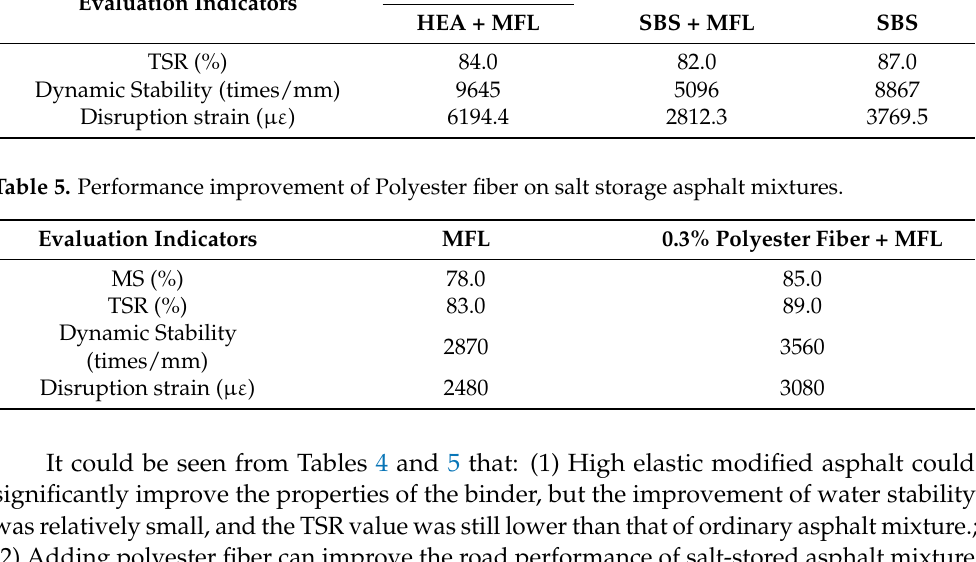
Table 4. Performance improvement of high elasticity modified asphalt on salt storage asphalt mixtures: HEA is high-elasticity asphalt; SBS is styrenic block copolymer.